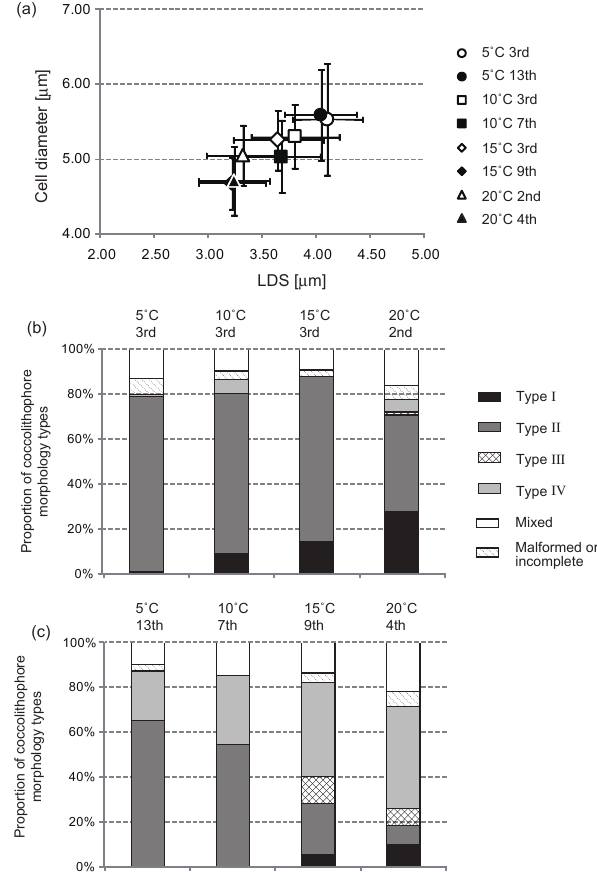
Figure 7. Relationships between LDS and temperature during growth (a) and proportions of morphotypes of coccoliths and coc- colithophore cells in E. huxleyi strain MR57N harvested at the early (b) and late (c) logarithmic growth phases. The number below tem- perature in (b) and (c) indicate the date harvested after initiating culture. For morphotypes, refer to Fig.